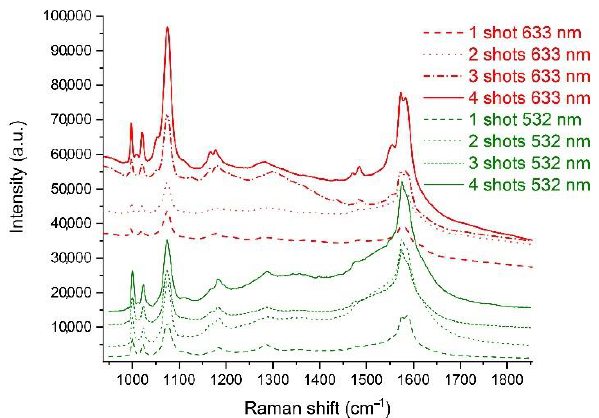
Figure 6. MPBA spectra for 633 and 532 nm laser excitations.